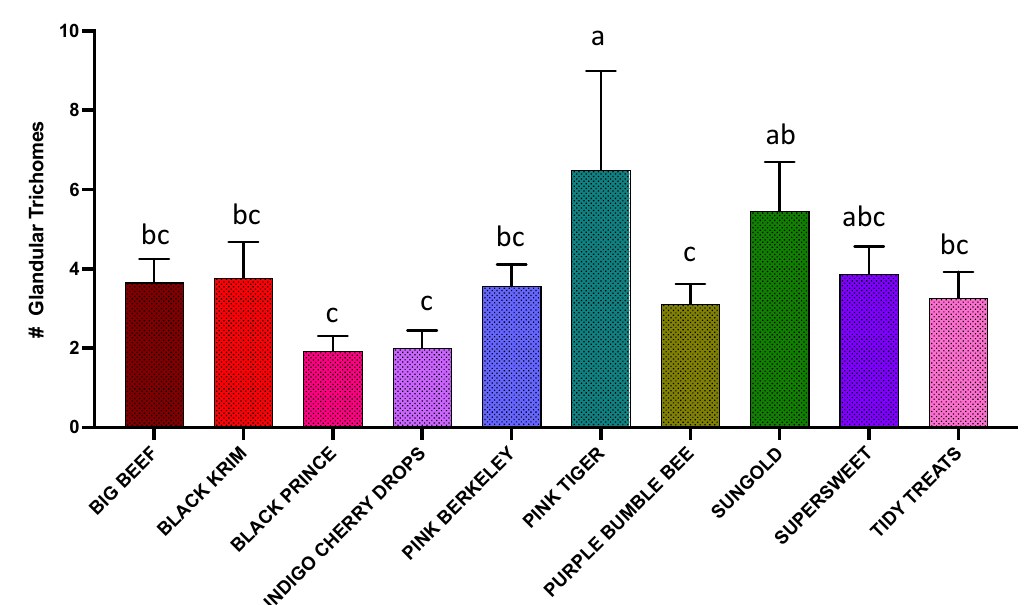
Fig. 4 The comparison of total number of glandular trichomes present in ten varieties of tomato